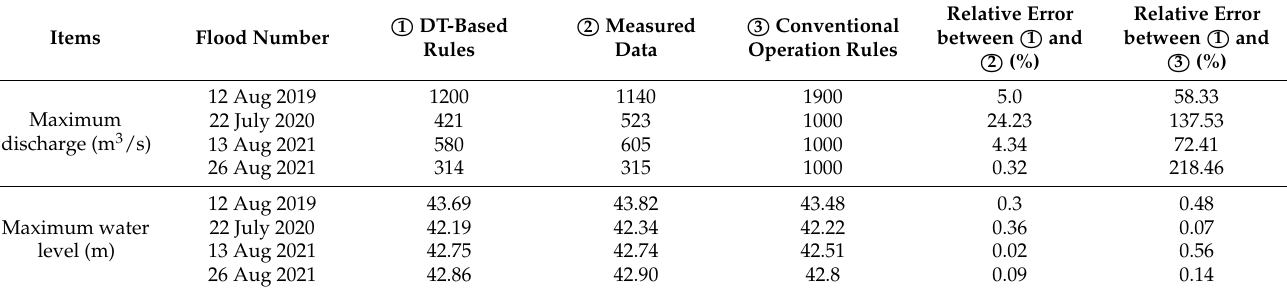
Figure 6. Operation hydrographs for 26 Aug 2021. Table 4. Maximum discharges and water levels according to operating schemes.